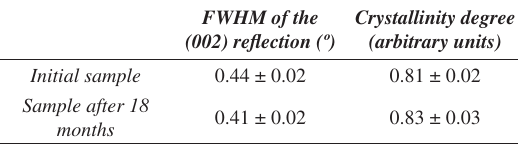
Table 1. Crystallinity analysis of the mineral sample over storage time. The FWHM of the (002) reflection was obtained by curve- fitting analysis of the XRD peaks (see Figure 2b). No statistically relevant changes were observed in the mineral sample after 18 months of storage. However, the occurrence of a slight increase in the crystallinity of the stored sample may be discussed. FWHM are presented as calculated values ± step size; crystallinity degrees are estimated as calculated values ±